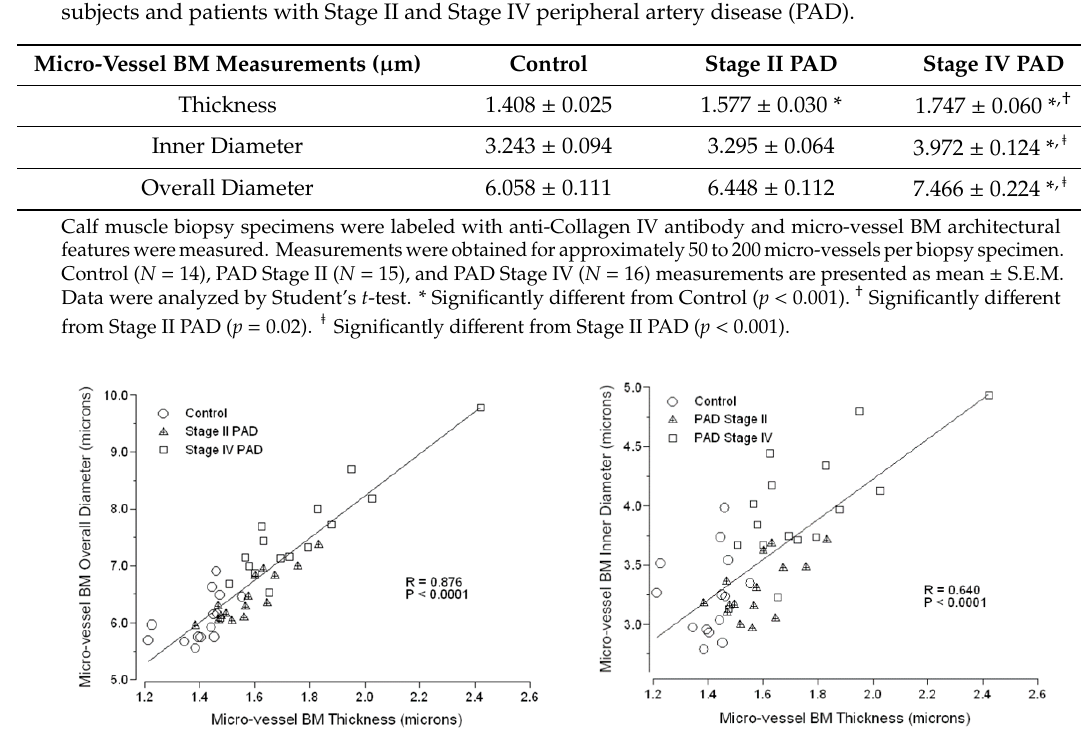
Figure 5. Dimensions of the architectural features of the micro-vessel basement membrane (BM) are highly coordinated across control subjects and PAD patients. BMs of calf muscle biopsy specimens were labeled with anti-Collagen IV antibody, and then micro-vessel BM architectural features, including thickness, inner diameter and overall diameter were measured. Measurements were obtained for approximately 50 to 200 micro-vessels per biopsy specimen of control subjects ( N = 14) and patients with Stage II ( N = 15) and Stage IV ( N = 16) PAD. Means per patient are plotted. Correlations were determined by Spearman Rho.